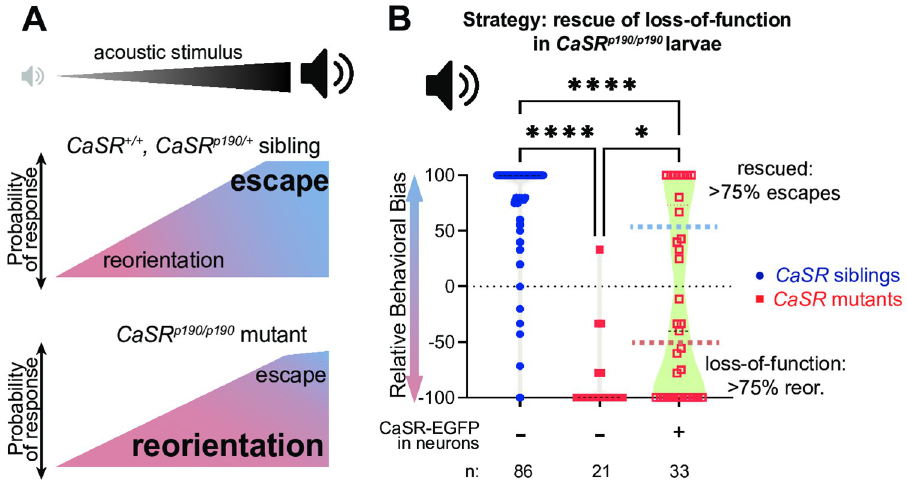
Fig 2. An example larval collection strategy based on rescue of a loss-of-function mutant phenotype. A) Schematic of behavioral bias for the escape versus reorientation decision of various larvae. At low stimulus intensities, WT larvae perform predominantly reorientations (pink). As stimulus intensity increases, WT larvae shift their preference towards escapes (light blue). CaSR mutant larvae, by contrast, are highly reorientation-biased across all stimulus intensities, although they do occasionally perform escapes. B) Example of a loss-of-function rescue strategy for collecting groups of larvae with divergent phenotypes. When responding to a strong acoustic stimulus, CaSR homozygous mutant larvae (red squares) are reorientation-biased relative to sibling controls (blue circles). Overexpressing CaSR in a variegated fashion in neurons in CaSR mutants (empty red squares) sometimes, but not always, rescues the mutant phenotype. We collected larvae in rescued (above light blue line) and non-rescued (below pink line) groups. Some data from Panel B also appears in Shoenhard, Jain, and Granato [19].